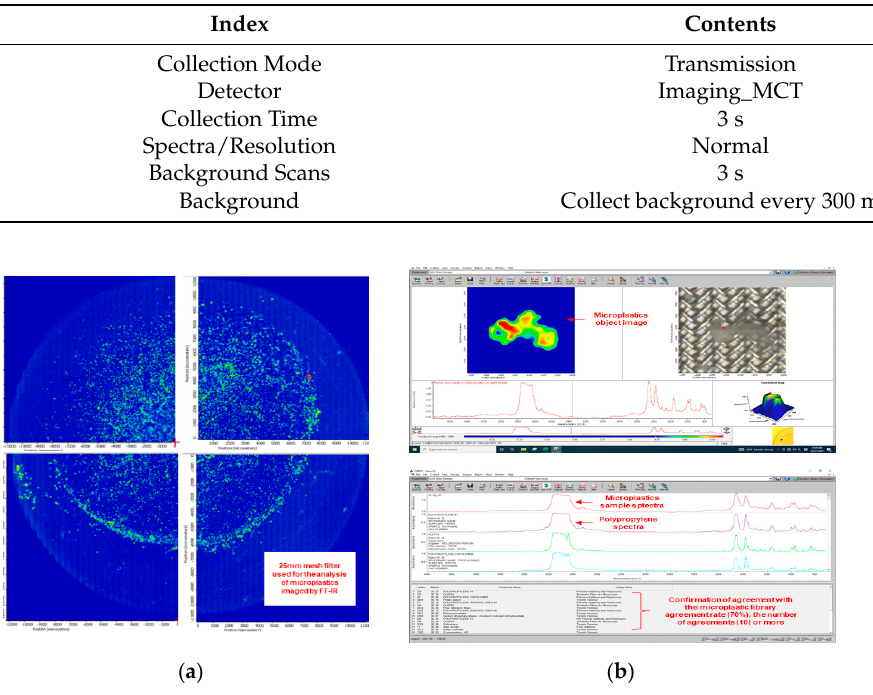
Figure 3. Microplastic mesh filter image and microplastic identification process: ( a ) A 25 mm mesh filter used for the analysis of microplastics imaged by FTIR microscope; ( b ) Determination of microplastics using software.